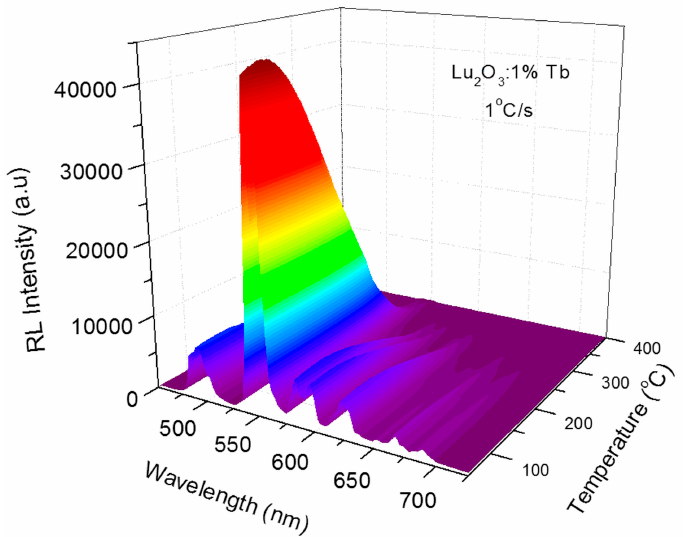
Figure 11. Temperature dependence of RL spectra of Lu 2 O 3 :Tb NP.